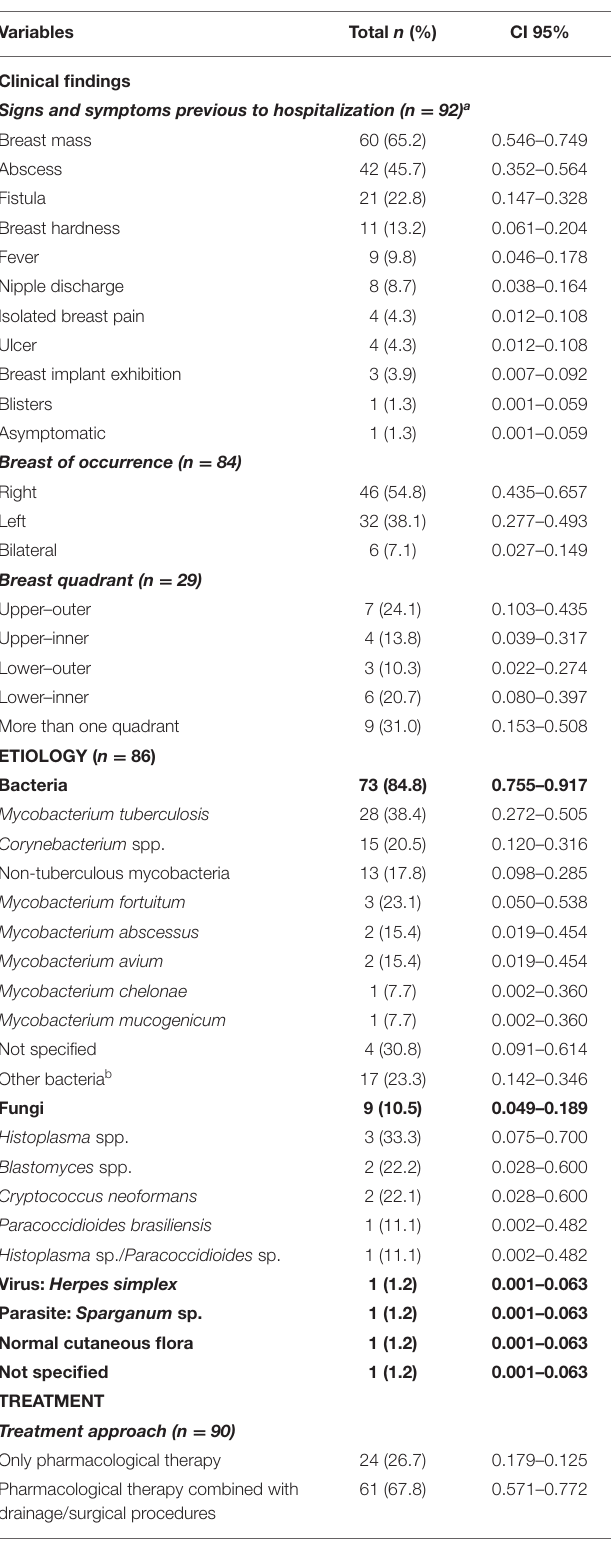
TABLE 2 | Clinical findings of cases, etiology, and treatment of non-lactational infectious mastitis in the